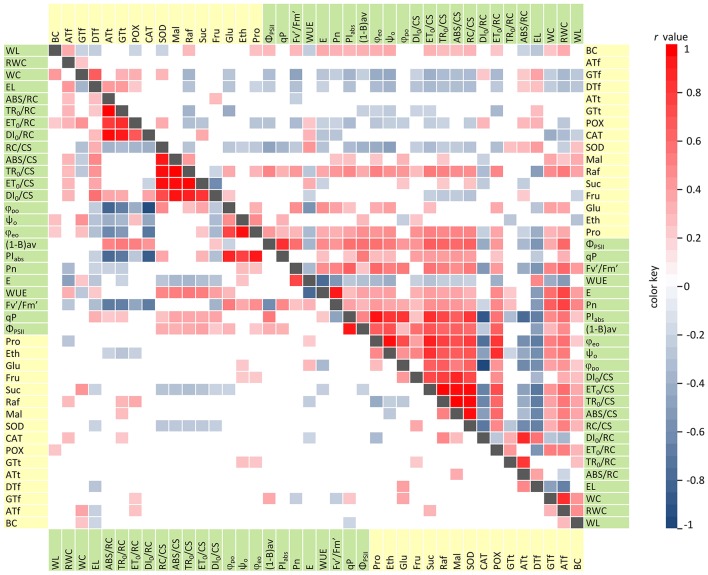
Correlation diagram for physiological (green) and biochemical (yellow) traits evaluated among RILs. Correlations under control conditions and drought stress are presented, respectively, in the lower and upper triangular. Statistically significant Pearson's coefficients (r, p < 0.05) are represented by colored matrix cells.